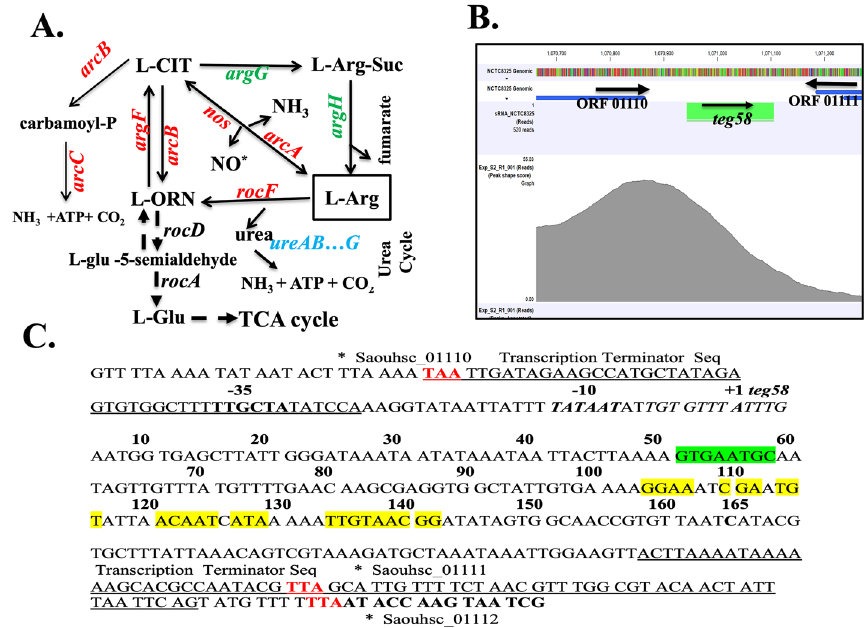
Figure 1. Characterization of sRNA teg58 . ( A ) Putative arginine synthesis and catabolic pathways in S. aureus . Adopted from Ibberson &Whiteley 39 . CIT, citrulline; Arg-Suc, arginosuccinate; ORN, ornithine. ( B ) Normalized occupancy profile for SarA peak located between sRNA teg58 (srn_2460) and Saouhsc_01110 open reading frame as analyzed by using CLC Genomics Workbench 11. Arrows indicated the direction of the genes or sRNA. ( C ) Nucleotide sequence of the teg58 region was shown and marked, indicating putative promoter region, start site as derived from primer extension data, transcriptional terminator and translational stop sequences (red) of the up- and down-stream genes. The ChIP-Seq motif and published SarA binding operator sequences 40 is in the same region as marked by red underline. Green and yellow marking indicate the potential interaction sites of argG and argH mRNAs/genes, respectively, with teg58 as determined by Freiburg IntaRNA Tools 41